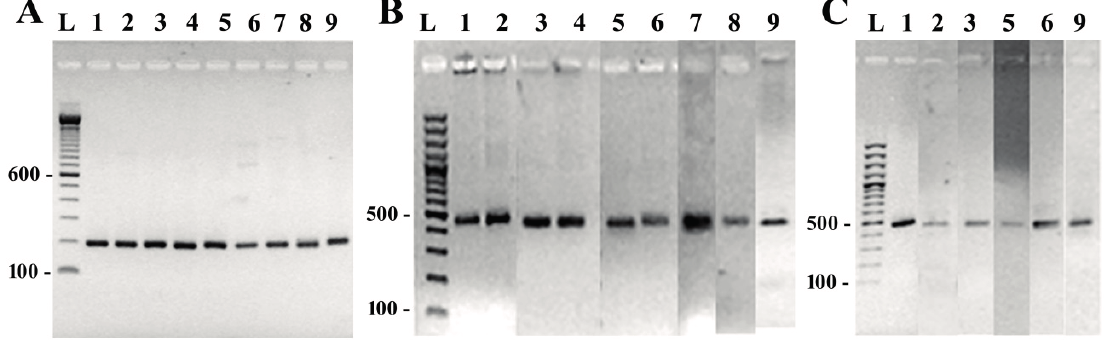
Figure 3. Electrophoretic separation of the amplification products obtained with primer pairs: ( A ) specific for SSU rRNA; ( B ) specific for a portion (440 bp) of the gene coding for the diatom elongation factor eEF1-a and ( C ) specific for a portion (470 bp) of the gene coding for the diatom silicic acid transporter gene ( SIT ). The panel of chromosomal DNA templates used corresponds to: 1. Nitzschia dissipata ; 2. Nitzschia palea ; 3. Navicula veneta ; 4. Surirella angusta ; 5. Craticula halophila ; 6. Eolimna minima ; 7. Achnanthidium minutissimum ; 8. Mayamaea atomus var. permitis and 9. Cyclotella meneghiniana . Lane L contains the 100 bp DNA ladder Invitrogen (Panel A) and 100 bp DNA ladder Fermentas (Panel B and